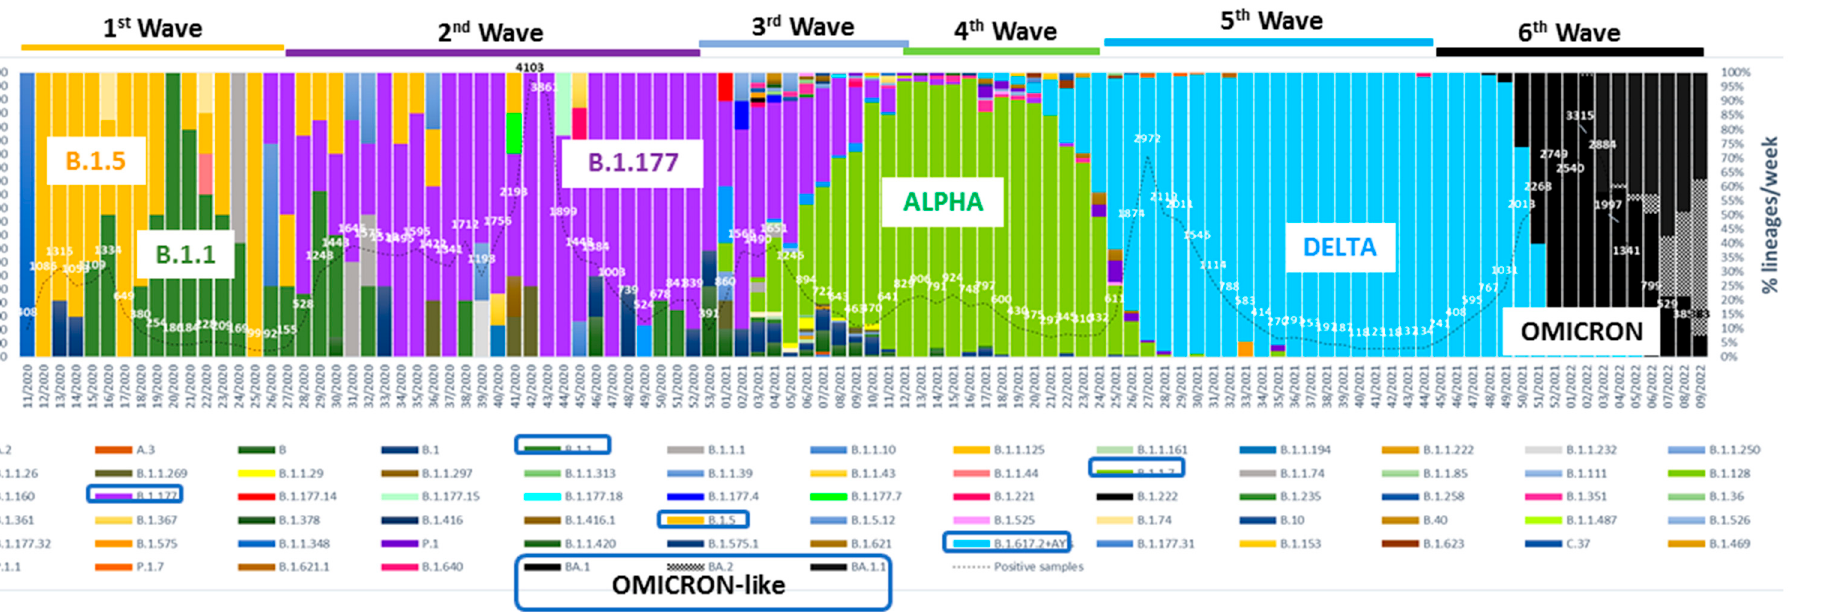
Figure 1. Week-by-week distribution of variants from March 2020 to present (February 2020). We have encircled the most prevalent variants in each pandemic wave. Pointed line with numbers ( · · · ) indicate the amount of positive cases detected in Vall d’Hebron Hospital per week. Pointed and slashed line ( · - · -) indicates vaccine coverage in Barcelona city with one dose and slashed line (- -) with double